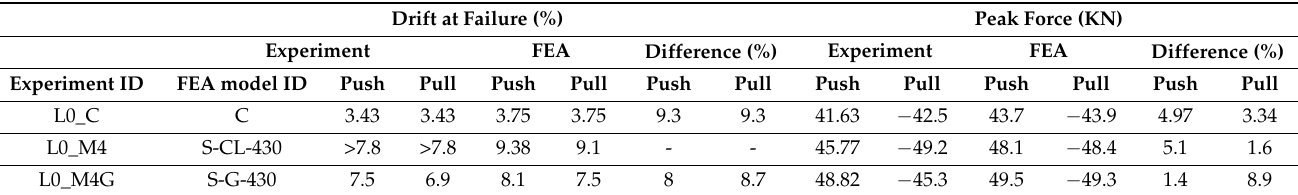
Table 1. Results of the Experiment and the FEM Models.